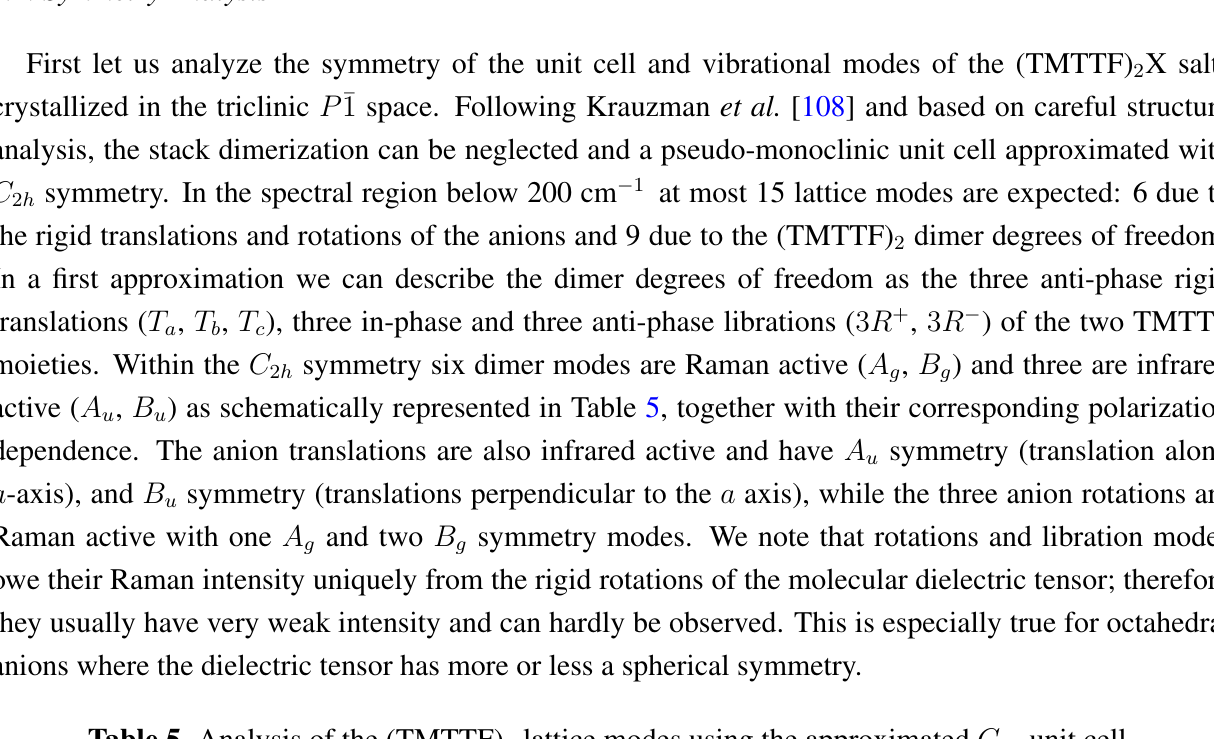
Table 5. Analysis of the (TMTTF)